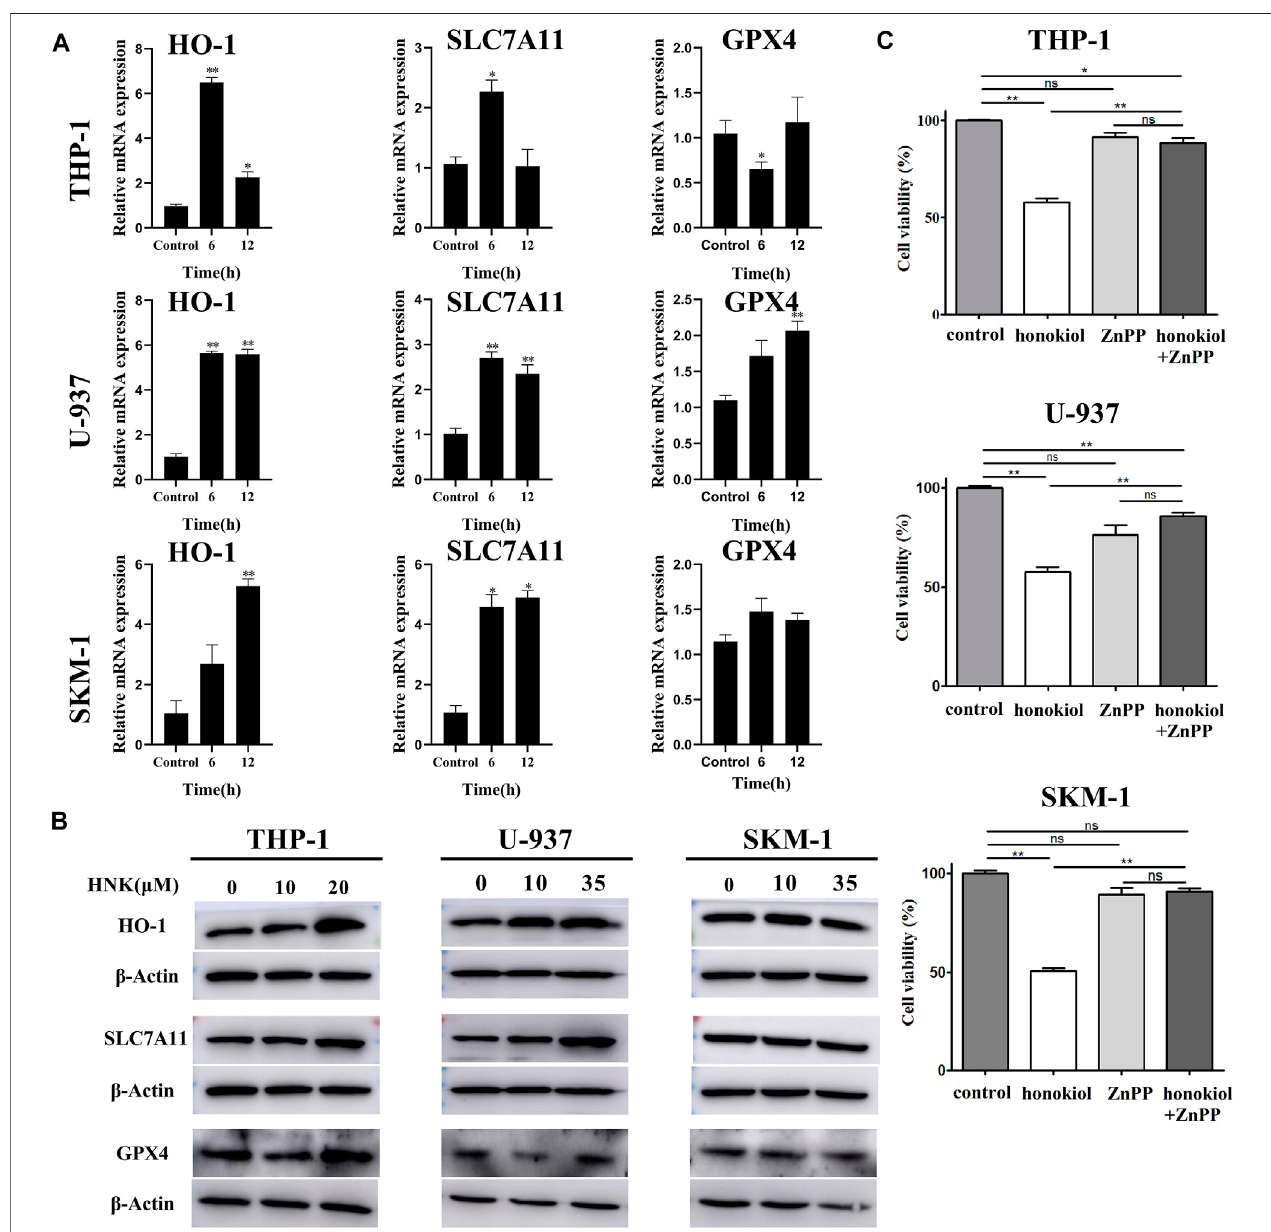
FIGURE 7 | HMOX1 is a necessary molecule to induce ferroptsis in AML cells induced by honokiol. (A) The mRNA expression of HMOX-1, SLC7A11, and GPX4 after honokiol treatment, showing Honokiol increased the expression of HO-1 and SLC7A11. The statistical analysis of mRNA expression was presented as bar graphs (*, p < 0.05; **, p < 0.01). (B) Western blot results on the protein expression of HMOX-1, SLC7A11, and GPX4 in 3 cell lines. (C) HMOX1 inhibitor ZnPP rescued the ferroptosis of AML cells induced by honokiol. Compared with honokiol treatment group, the cell viability of honokiol combined with ZnPP treated group was signi fi cantly increased (**, p <